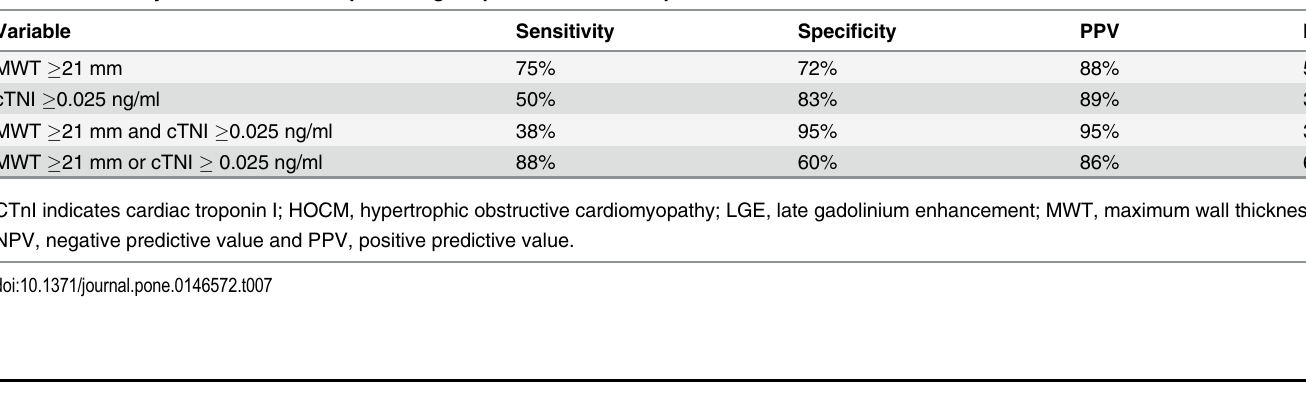
Table 7. Accuracy of MWT and cTnI in predicting the presence of LGE in patients with HOCM. Variable Sensitivity Speci fi city PPV NPV 75% 50%